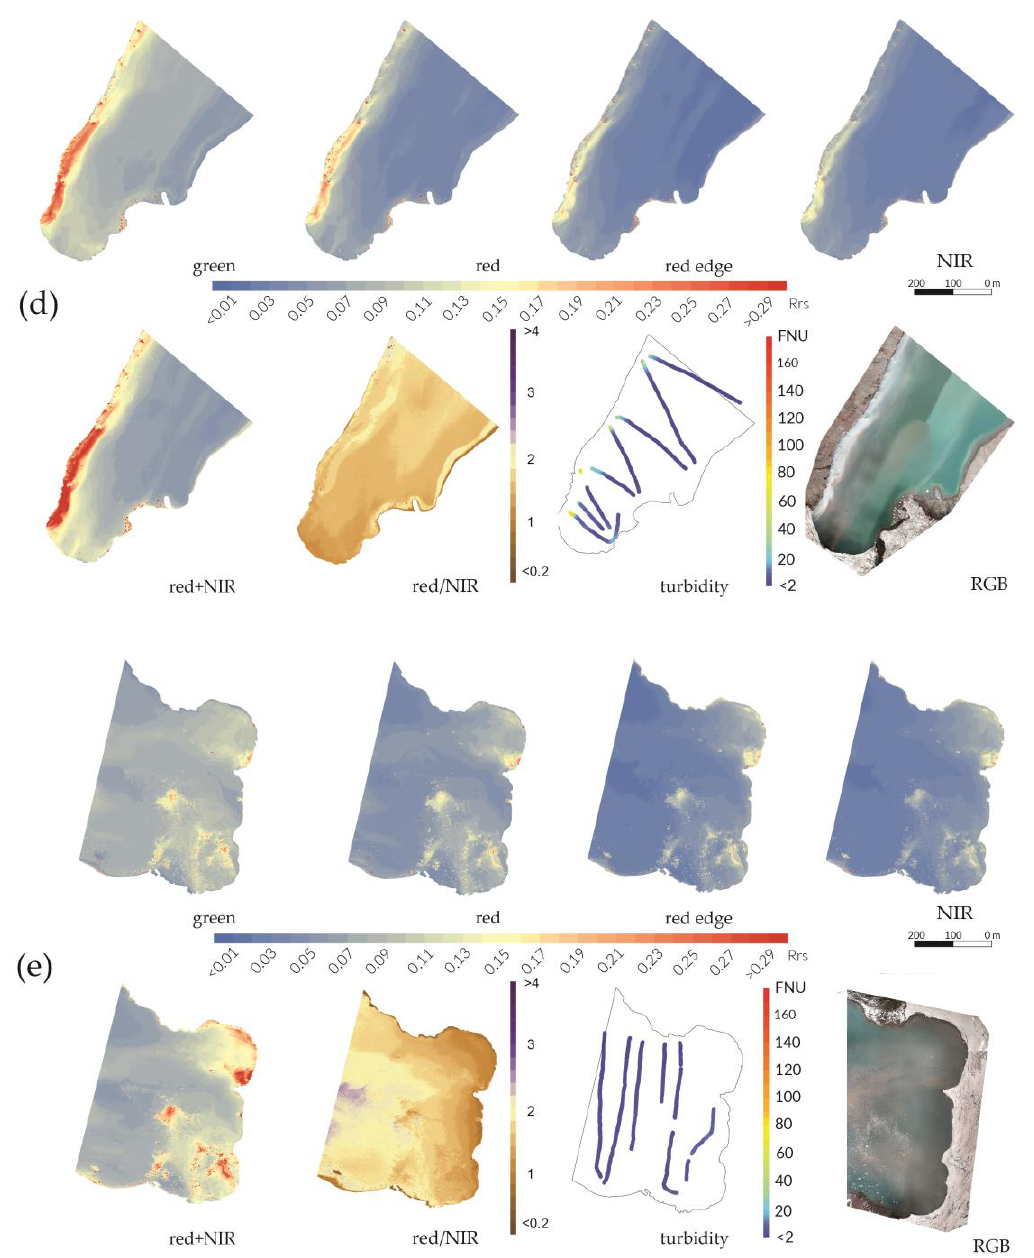
Figure 7. Reflectance maps, orthophotomaps, and turbidity maps of the selected glacier bays in Admiralty Bay: ( a ) Ecology Glacier, ( b ) Dera Icefall, ( c ) Zalewski Glacier 1, ( d ) Zalewski Glacier 2, and ( e ) Krak Glacier.